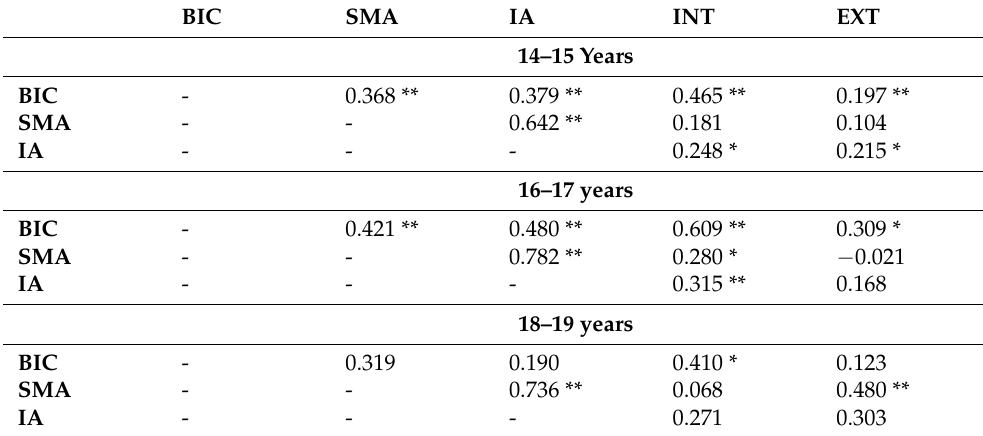
Table 4. Bivariate correlations between age-related variables of